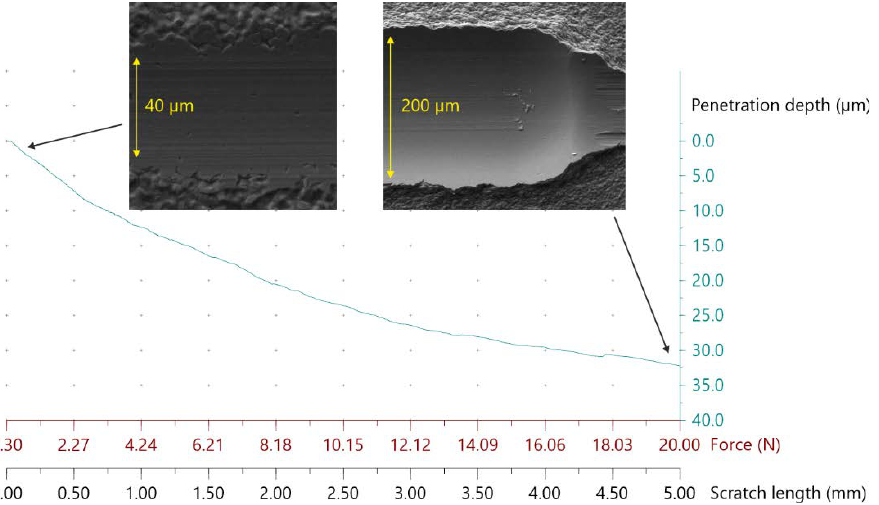
Figure 8. Scratch-testing results: penetration depth vs. exerted indenter force together with SEM images of scratch ends.